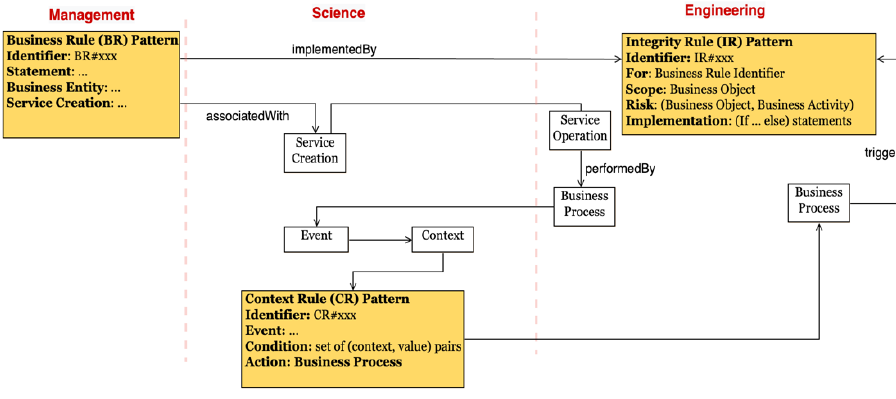
Fig. 3. RuCBS patterns’ relationships for an implicit